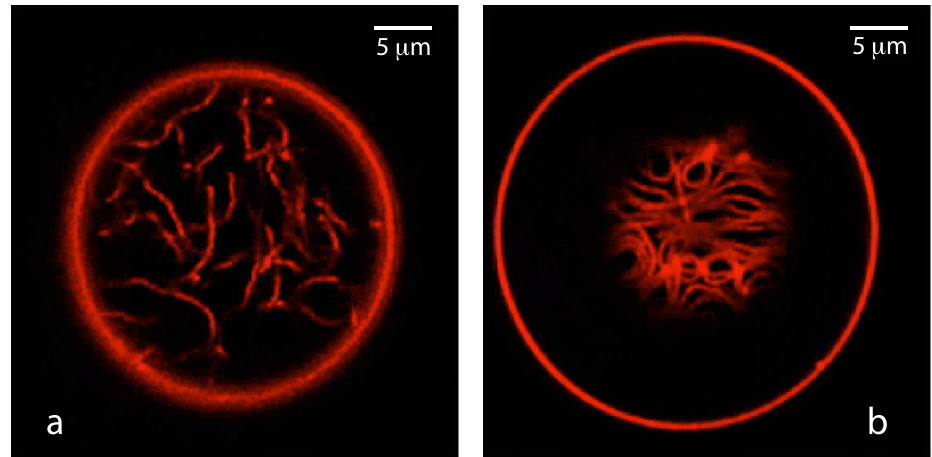
Figure 19. Patterns of flexible nanotubes formed by liquid-disordered membranes (red) exposed to aqueous solutions of PEG and dextran. All tubes protrude into the vesicle interior: ( a ) Disordered pattern of tubes freely suspended within the PEG-rich droplet enclosed by the vesicle, corresponding to the VM-B pattern in Figure 18; and ( b ) Thin layer of tubes adhering to the αβ interface between the PEG-rich and the dextran-rich phase, providing an example for the VM-C pattern in Figure 18. The width of the fluorescently labeled nanotubes is below the optical diffraction limit and of the order of 100nm